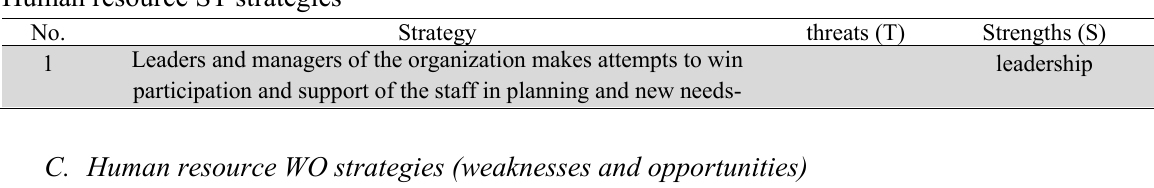
Human resource SO strategies No. Strategy Opportunities (O) Strengths (S) Attendance of the manager in ceremonies to 1 appreciation the staff and welcome the newcomers B. Human resource ST strategies (strengths and threats)